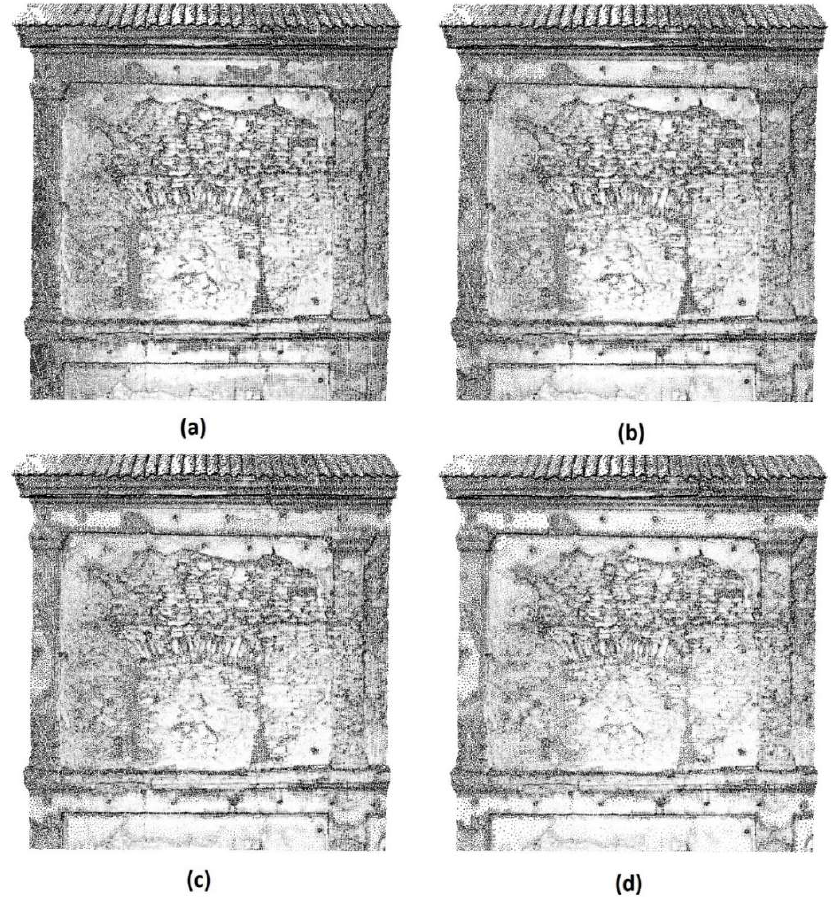
Figure 8. Data 2—examples of dilution: a = 0.02 m in all cases; ( a ) uniform dilution (i.e., a = 0.02 m); ( b ) b = 0.04 m; ( c ) b = 0.06 m; ( d ) b = 0.10 m. Table 3. Results of dilution of the Data 2 cloud—numbers of points and RMSDs (R = 0.10 m).